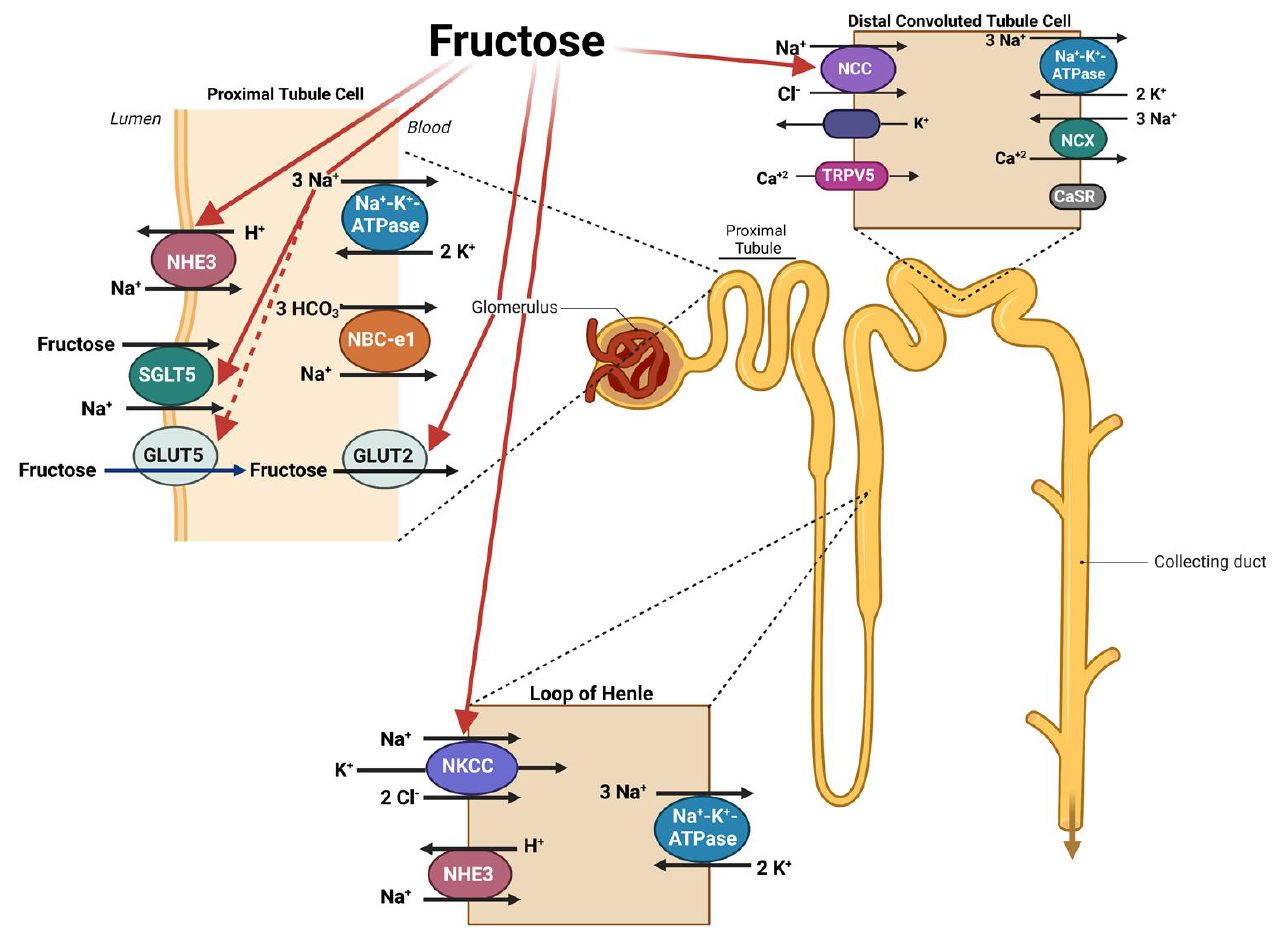
Figure 5. A schematic diagram depicting the stimulatory effect of fructose on salt transporters in the kidney tubules. Red arrows indicate kidney transporters that are affected by elevated levels of dietary fructose, including SGLT5 and GLUT5 which move luminal fructose into the proximal tubule and GLUT2 which acts to remove intracellular fructose from the cell. Created with Biorender. It is worth mentioning that long-term fructose consumption causes insulin resistance and increased circulating levels of insulin. The latter can contribute to enhanced salt absorption in the kidneys by activating NHE3, NKCC2, NCC, and the ENaC in the proximal tubule, the thick ascending limb of Henle, the distal convoluted tubule, and the collecting duct, respectively [35,36,38–43]. Enhanced absorption of salt is associated with increased oxygen intermediates, and oxidative injury